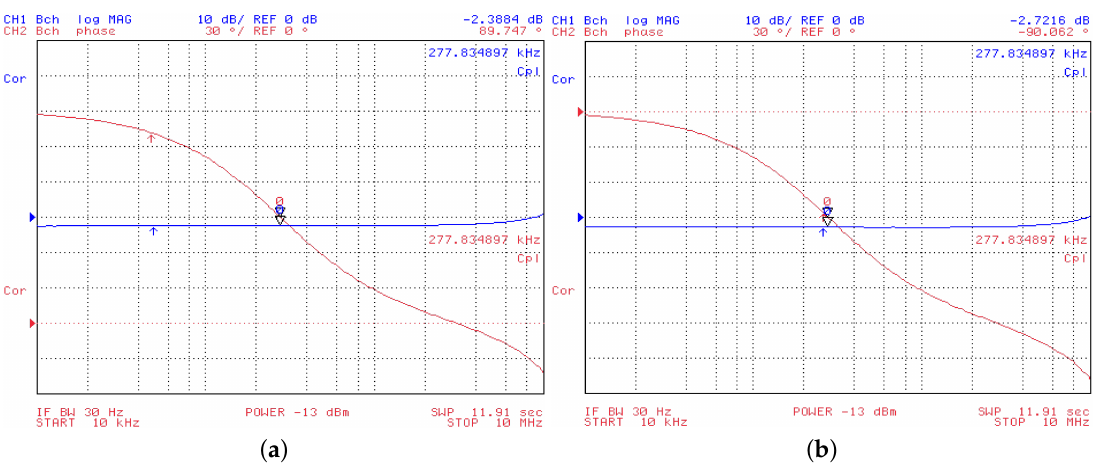
Figure 4. Measured magnitude (blue line) and phase (red line) responses of the VM APF for outputs: